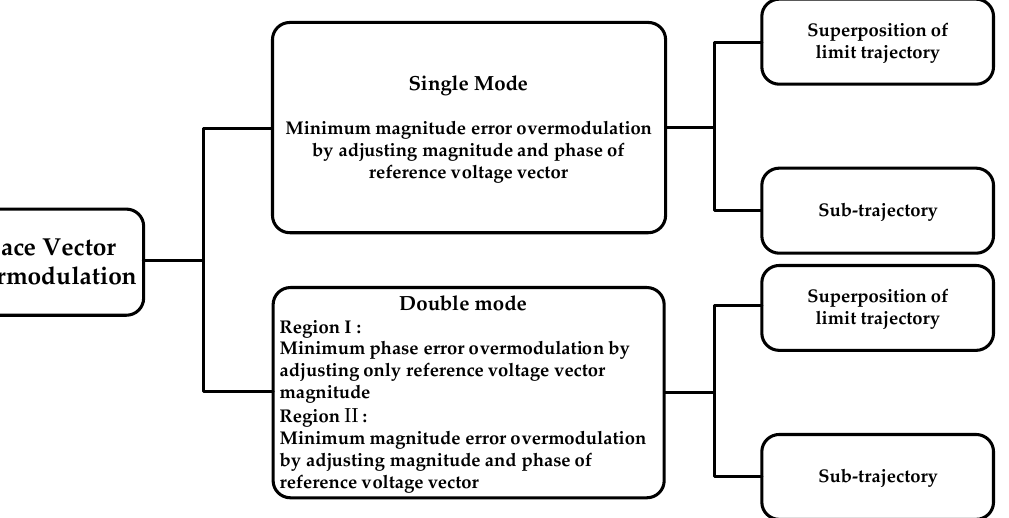
Figure 16. Classification of space vector overmodulation technology.